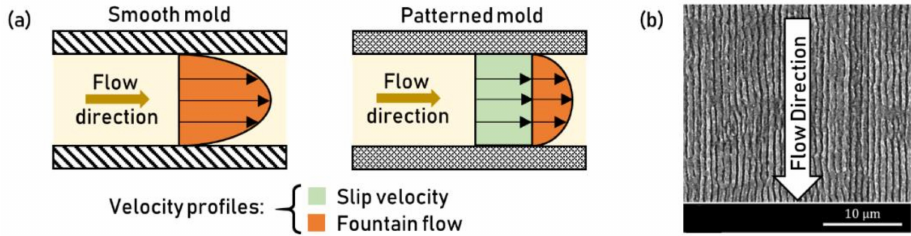
Figure 17. ( a ) Effect of wall slip on the polymer velocity profile in a thin-wall injection molding cavity; ( b ) ripples aligned along the polymer flow to facilitate wall